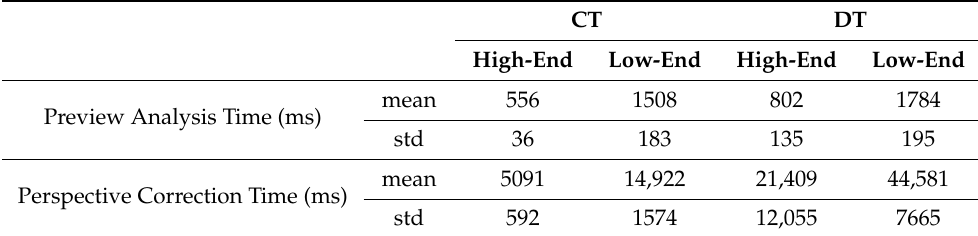
Table 10. Processing times for high-end and low-end mobile